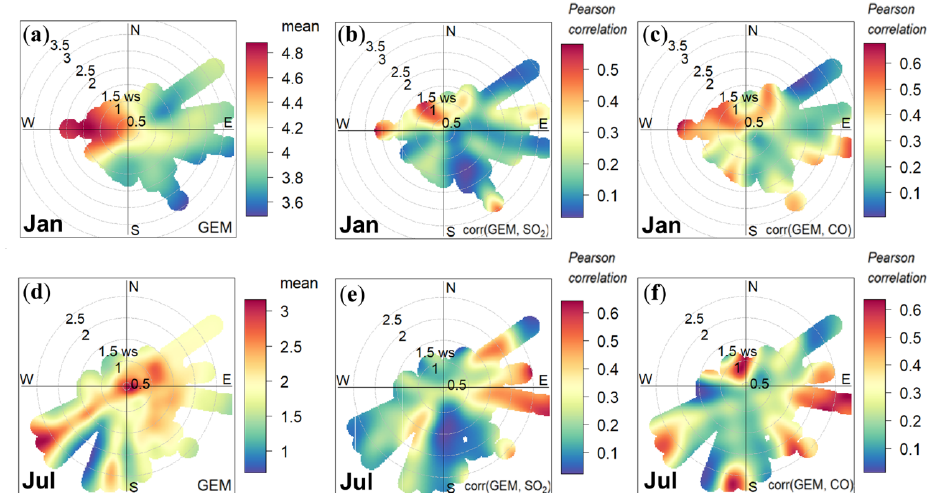
Figure 4. Bivariate polar plots of GEM concentrations (a, d) , the correlation coefficients of GEM with SO 2 (b, e) , and CO (c, f) as a function of WS and WD in January and July during the whole study period. Note that GEM is measured in nanograms per cubic meter (ngm − 3 ), wind speed in meters per second (ms − 1 ), and wind direction in degrees ( ◦